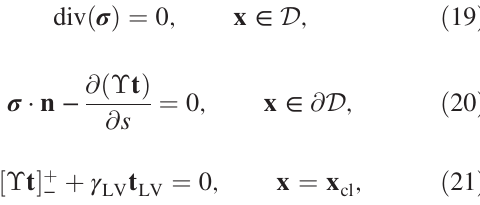
=G at the contact line, as a function of the stretch at the contact line λ FIG. 4. Marangoni stress σ nt positive or negative depending on whether the stretch at the tip is larger or smaller than λ ∞ . Open circles are obtained by FEM, the solid line from similarity solutions described in Sec. IV in combination with Neumann ’ s law. The grids represent geometry of the ridge and deformation within it for negative (A) and positive (B) Marangoni stresses, as obtained from the similarity solutions. The gray lines denote the undeformed grid, and the arrows indicate the direction of the Marangoni